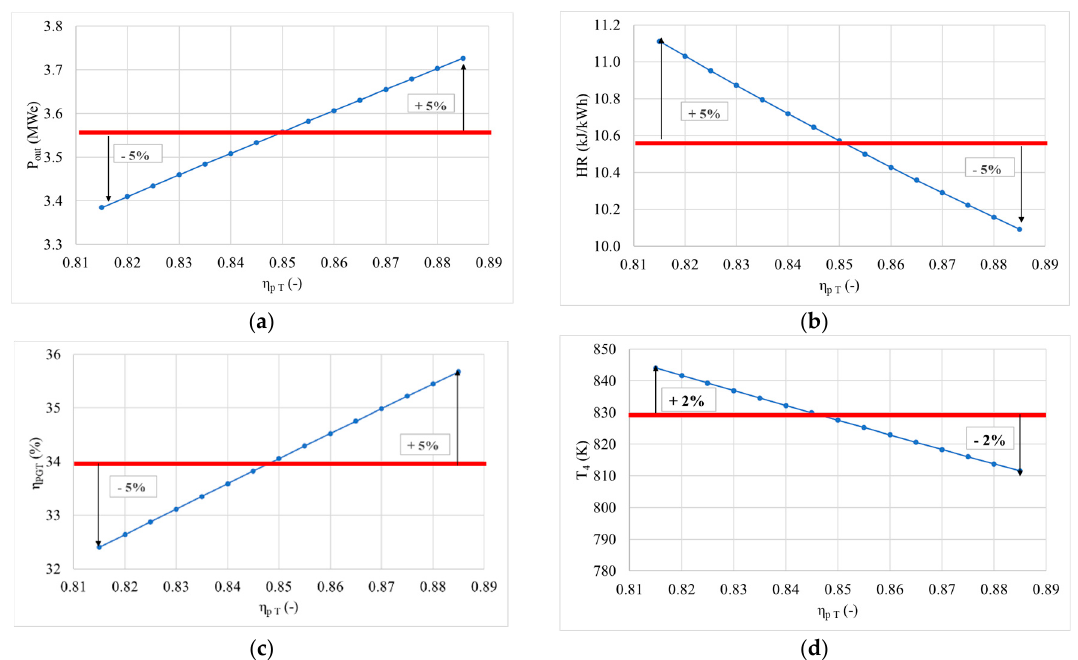
Figure 11. Change of gas turbine cycle outlet parameters in function of turbine polytropic efficiency ( a ) power change in function of turbine polytropic efficiency, ( b ) heat rate change in function of turbine polytropic efficiency, ( c ) gas turbine plant efficiency change in function of turbine polytropic efficiency and ( d ) change of temperature of the expanded products at the gas turbine outlet in function of turbine polytropic efficiency.